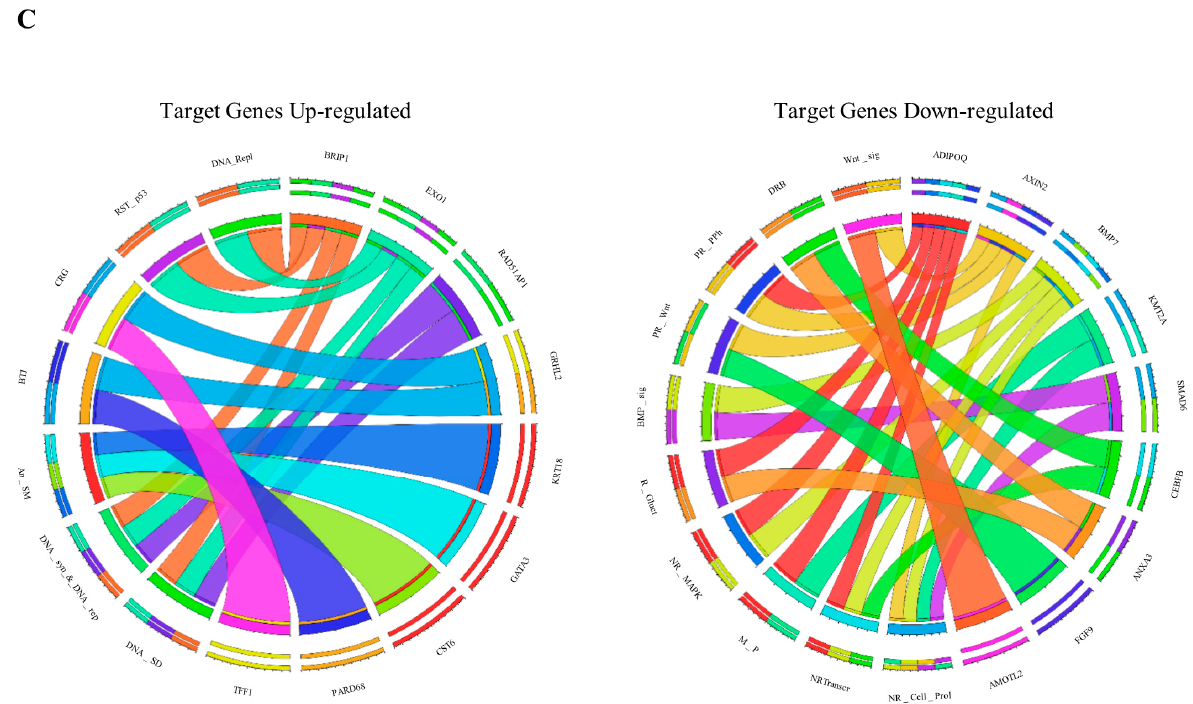
Figure 1. Transcriptomics profiling of human breast cancer. ( A ) Boxplot of CtBP2 expression level (logarithmic scale) in breast invasive carcinoma samples and matched normal samples retrieved from TCGA. ( B ) Hierarchical clustering and heatmap for CtBP2 target genes in invasive breast carcinoma compared to normal samples. The colors represent different expression levels that increase from green to red. ( C ) Circle spots show the most up-regulated (left panel) and downregulated (right panel) genes, and the cognate enriched pathways in human breast tissues. Up-circle pathways abbreviations: DNA SD (strand displacement); DNA syn and DNA rep (DNA synthesis involved in DNA repair); an SM (anatomical structure morphogenesis); BJT (bicellular tight junction assembly); CRG (cancer-related genes); RST p53 (regulation of signal transduction by p53 class mediator); and DNA Reply (DNA replication). Down-circle pathway abbreviations: NR Cell Prol (negative regulation of cell proliferation); MP (membrane depolarization); NR MAPK (negative regulation of MAP kinase activity); NRTranscr (negative regulation of transcription, DNA-templated); R Gluck (glucocorticoid response); BMP sig (BMP-signaling pathway); PR Wnt (positive regulation of canonical Wnt-signaling pathway); PR PPh (positive regulation of protein phosphorylation); DRB (defense response to bacterium); and Wnt sig (Wnt-signaling